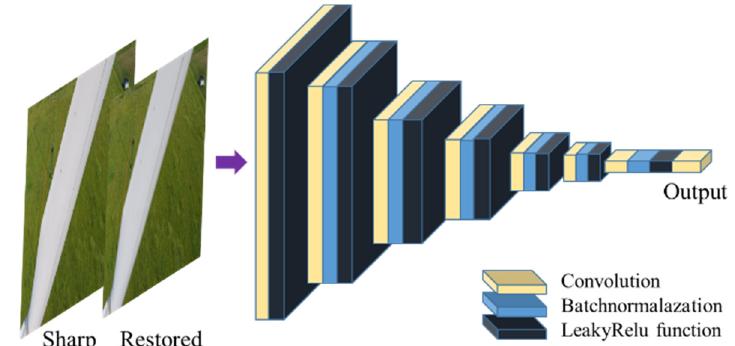
Figure 11. Discriminator structure.